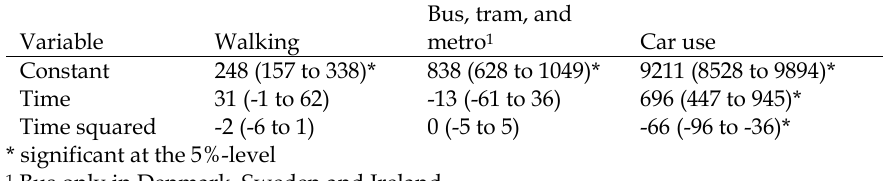
Multi-level regression analyses on distance on foot and by car per capita (95%